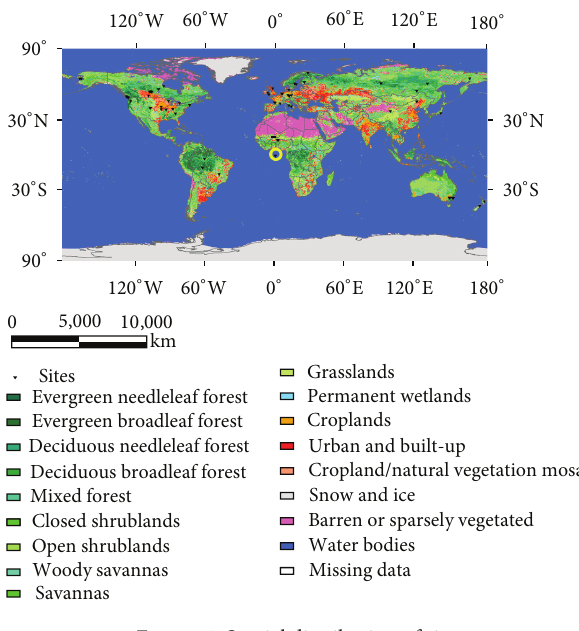
Figure 1: Spatial distribution of sites.